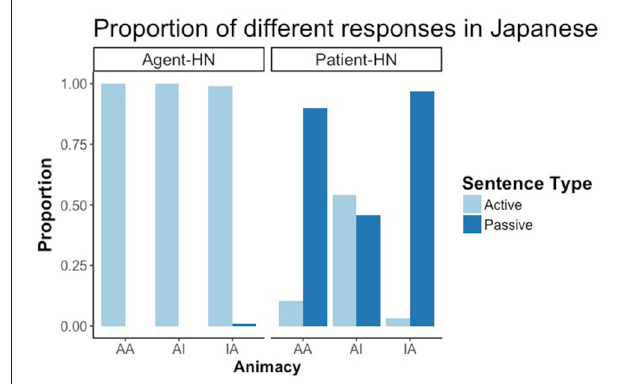
FIGURE 7 | Proportion of active, passive and impersonal responses in RCs with the Agent as HN and the Patient as HN in Japanese.